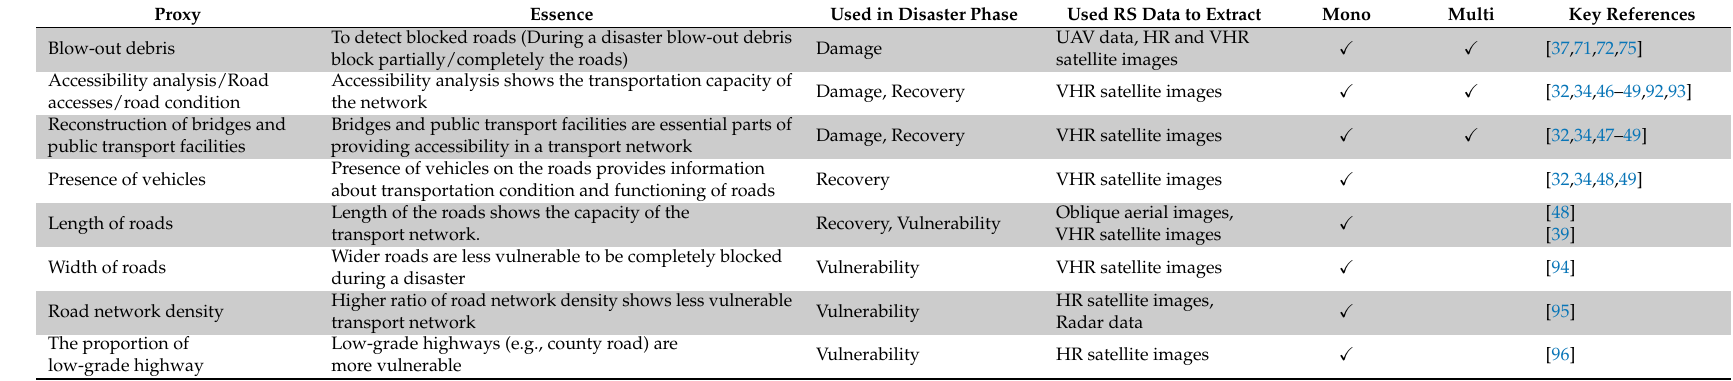
Table 2. Remote sensing-based built-up proxies for urban DRM, Transport category. Mono and Multi refer to mono-temporal and multi-temporal RS data, respectively, used for the extraction, respectively.